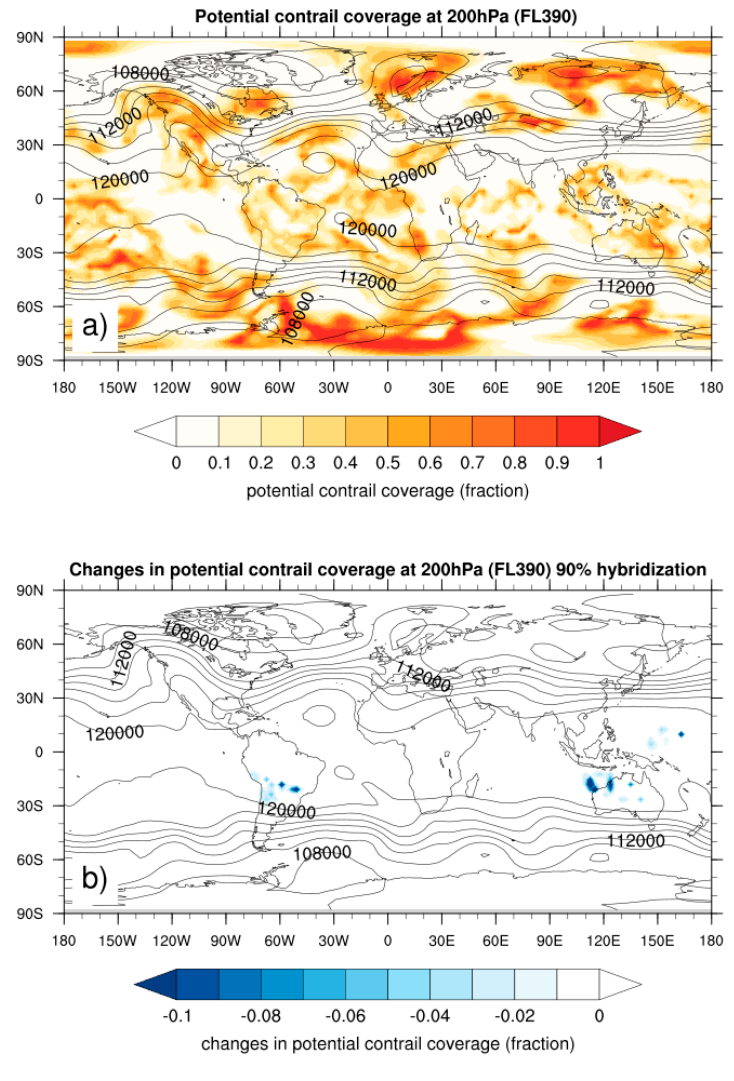
Figure 10. The PCC (contour) and geopotential (black contour; m 2 s − 2 ) at 200 hPa (FL390) on a specific day: ( a ) conventional aircraft; ( b ) absolute changes caused by HEA with 90% electric power.